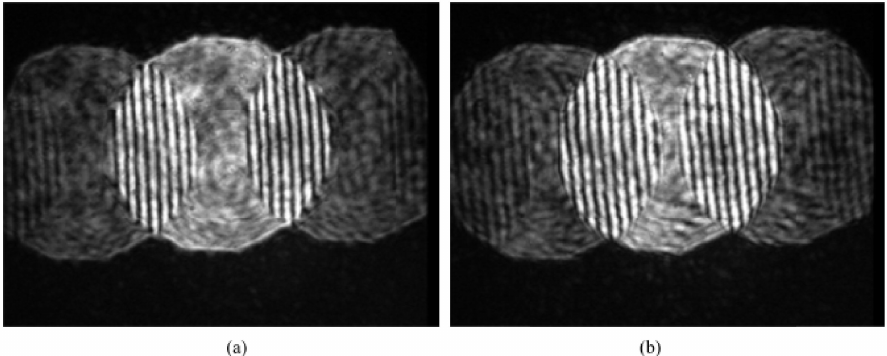
Figure 7. Distribution of interferometry pattern detected by CCD sensor: ( a ) wafer at focus position; ( b ) wafer at defocus position.